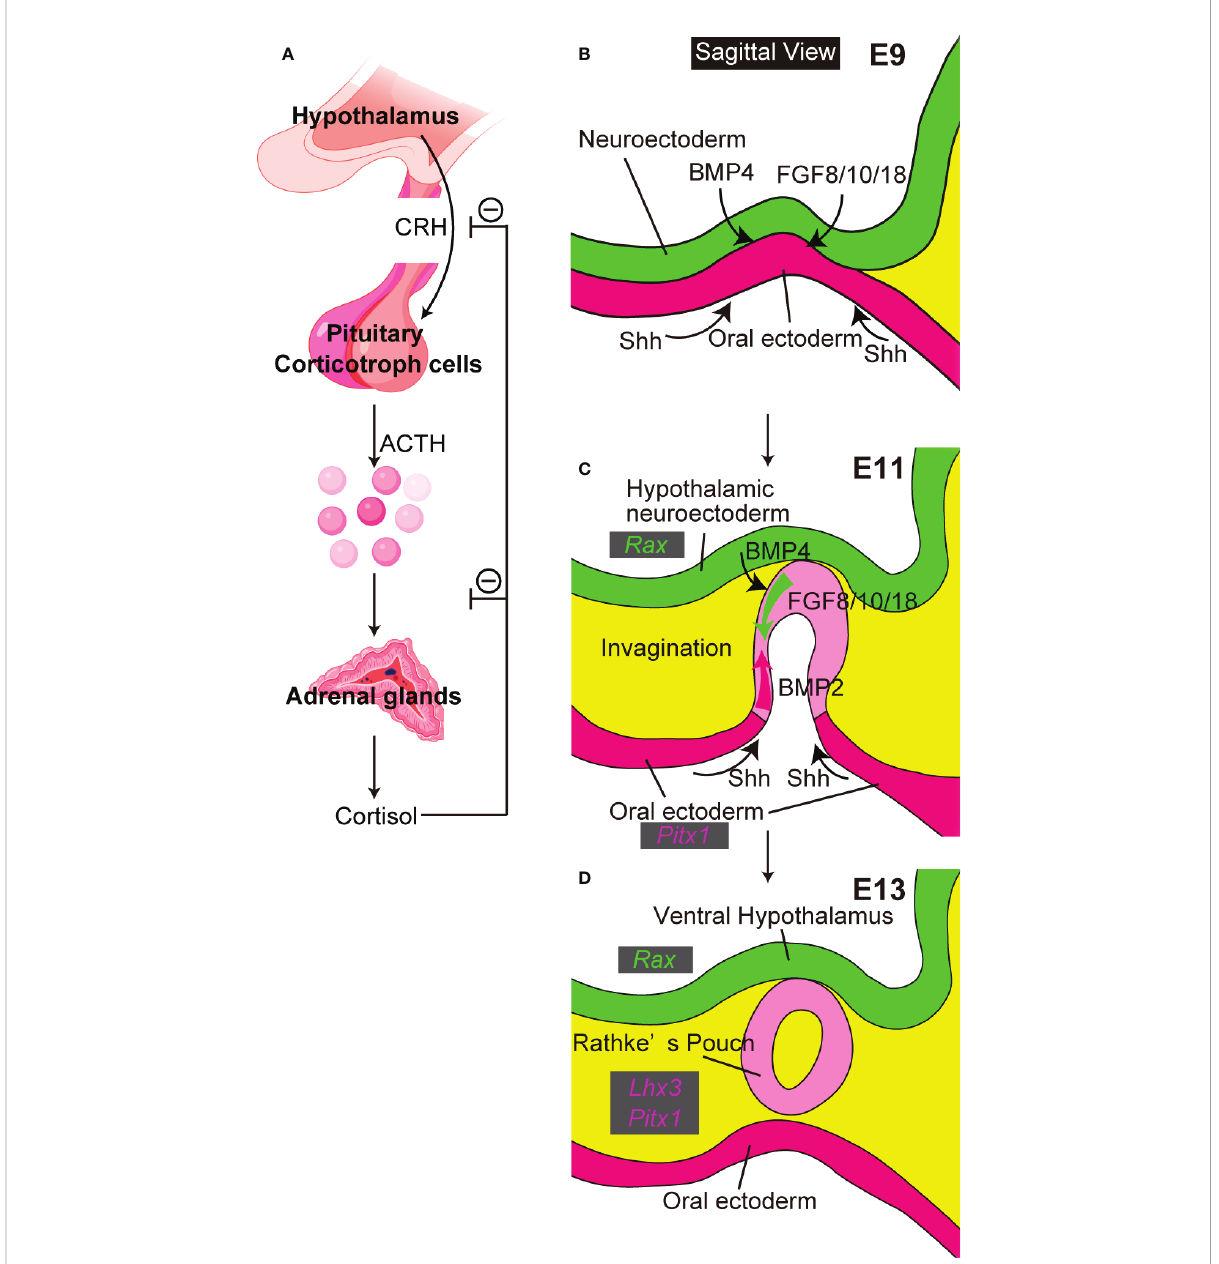
FIGURE 1 The close relationship between hypothalamus and pituitary. (A) The hypothalamus-pituitary-adrenal axis. Created with BioRender (https:// biorender.com). (B – D) Pituitary organogenesis in mice. The ventral diencephalon provides BMP4 and FGF 8/10/18. The oral ectoderm provides signals that activate sonic hedgehog (Shh) (B) . Opposing dorsal ! ventral FGF8/10/18 and ventral dorsal BMP2 gradients are crucial for pituitary organogenesis (C) . Ventral hypothalamus expresses Rax . Non-neural oral ectoderm expresses Paired like homeodomain 1 ( Pitx1 ). LIM homeobox protein 3 ( Lhx3 ) encodes an early pituitary